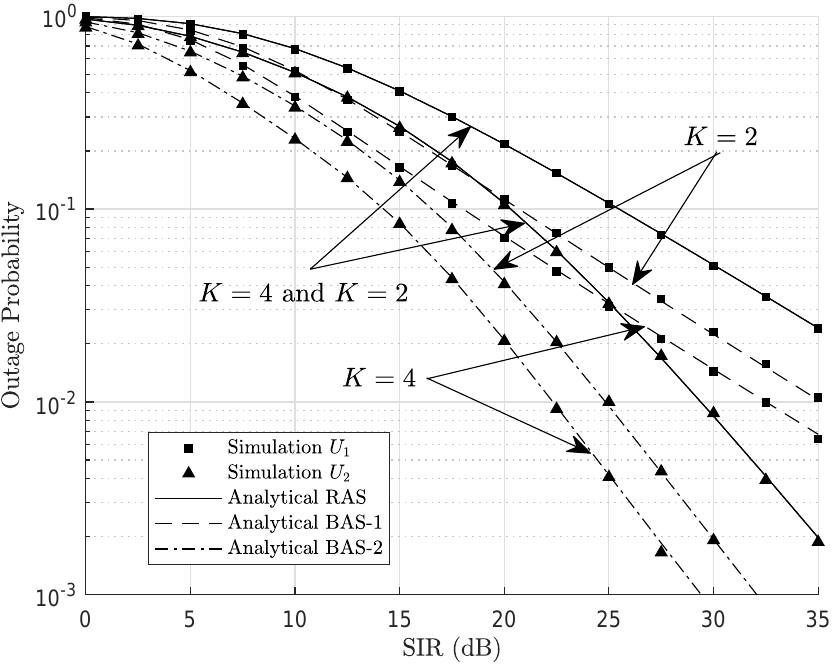
Figure 2. Outage Probability at each user versus the average SIR (dB).